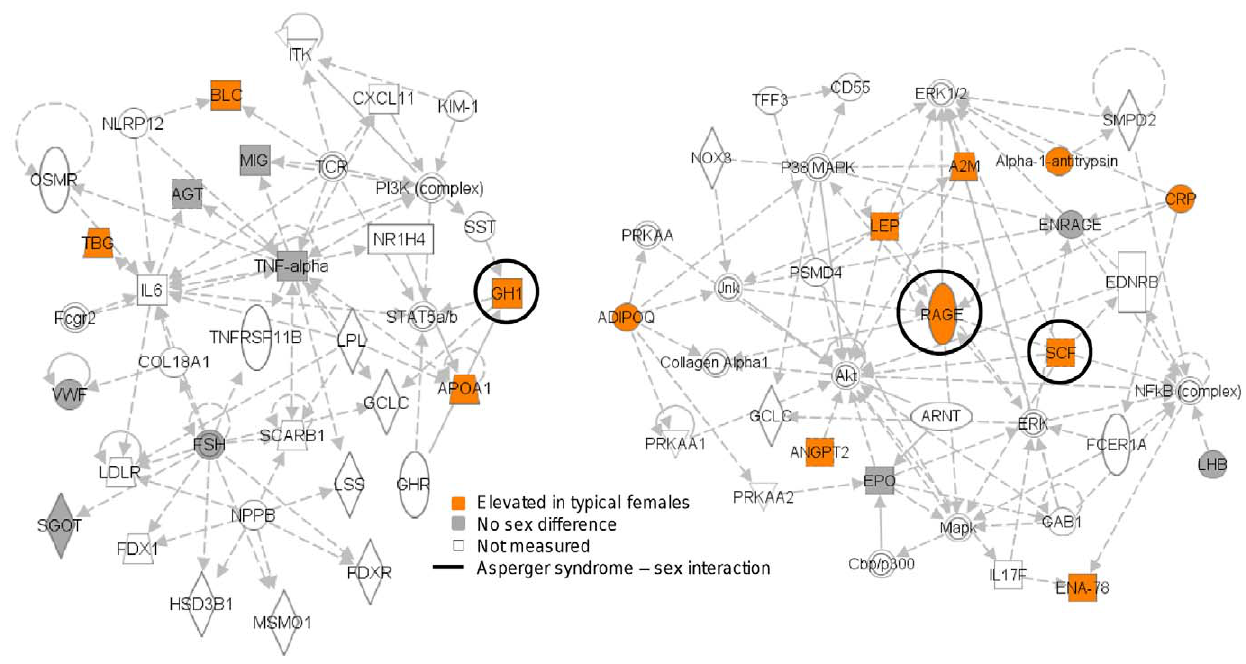
Figure 3. Sex-specific effects in networks for Asperger syndrome. Top networks of the cluster of molecules associated with energy production, fatty acid metabolism, and hormone levels from Ingenuity Pathway Knowledgebase software. Individual molecules are coloured according to significant sex difference in controls. Molecules with significant sex-disease interactions from [34] are circled. A2M (alpha 2 macroglobulin), ADIPOQ (adiponectin), RAGE (receptor for advanced glycosylation end products), ANGPT2 (angiopoietin 2), ARNT (aryl hydrocarbon receptor nuclear translocator), CRP (C-reactive protein), ENA-78 (epithelial derived neutrophil activating protein 78), EDNRB (endothelin receptor type B), EPO (erythropoietin), ERK (extracellular-signal-regulated kinase), FCER1A (Fc fragment of IgE, high affinity I, receptor for alpha polypeptide), GAB1 (GRB2-associated binding protein 1), GCLC (glutamate-cysteine ligase, catalytic subunit), IL17F (interleukin-17F), Jnk (c-Jun N-terminal kinase), SCF (stem cell factor), LEP (leptin), LHB (luteinizing hormone beta polypeptide), Mapk (mitogen-activated protein kinase), NFkB (complex) (nuclear factor of kappa light polypeptide gene enhancer in B-cells), NOX3 (NADPH oxidase 3), P38 MAPK (P38 mitogen-activated protein kinase), PRKAA1 (protein kinase, AMP-activated, alpha 1 catalytic subunit), PRKAA2 (protein kinase, AMP-activated, alpha 2 catalytic subunit), PSMD4 (proteasome (prosome, macropain) 26S subunit, non-ATPase, 4), SMPD2 (sphingomyelin phosphodiesterase 2, neutral membrane (neutral sphingomyelinase)), TFF3 (trefoil factor 3), AGT (angiotensinogen), APOA1 (apolipoprotein AI), COL18A1 (collagen, type XVIII, alpha 1), CXCL11 (chemokine (C-X-C motif) ligand 11), BLC (B lymphocyte chemoattractant), MIG (monokine induced by gamma interferon), Fcgr2 (Fc gamma R2), FDX1 (ferredoxin 1), FDXR (ferredoxin reductase), FSH (follicle stimulation hormone), GCLC (glutamate-cysteine ligase, catalytic subunit), GH (growth hormone), GHR (growth hormone receptor), SGOT (serum glutamic oxaloacetic transaminase), KIM-1 (kidney injury molecule 1), HSD3B2 (hydroxy-delta-5-steroid dehydrogenase, 3 beta- and steroid delta-isomerase 2), IL6 (interleukin-6), ITK (IL2-inducible T-cell kinase), LDLR (low density lipoprotein receptor), LPL (lipoprotein lipase), LSS (lanosterol synthase (2,3-oxidosqualene-lanosterol cyclase)), MSMO1 (methylsterol monooxygenase 1), NLRP12 (NLR family, pyrin domain containing 12), NPPB (brain natriuretic peptide), NR1H4 (nuclear receptor subfamily 1, group H, member 4), OSMR (oncostatin M receptor), PI3K (complex) (phosphoinositide-3-kinase), SCARB1 (scavenger receptor class B, member 1), TBG (thyroxine binding globulin), SST (somatostatin), Stat5a/ b (signal transducer and activator of transcription a/b), TCR (T-cell receptor), TNF-alpha (tumor necrosis factor-alpha), TNFRSF11B (tumor necrosis factor receptor superfamily, member 11b), VWF (von Willebrand factor).